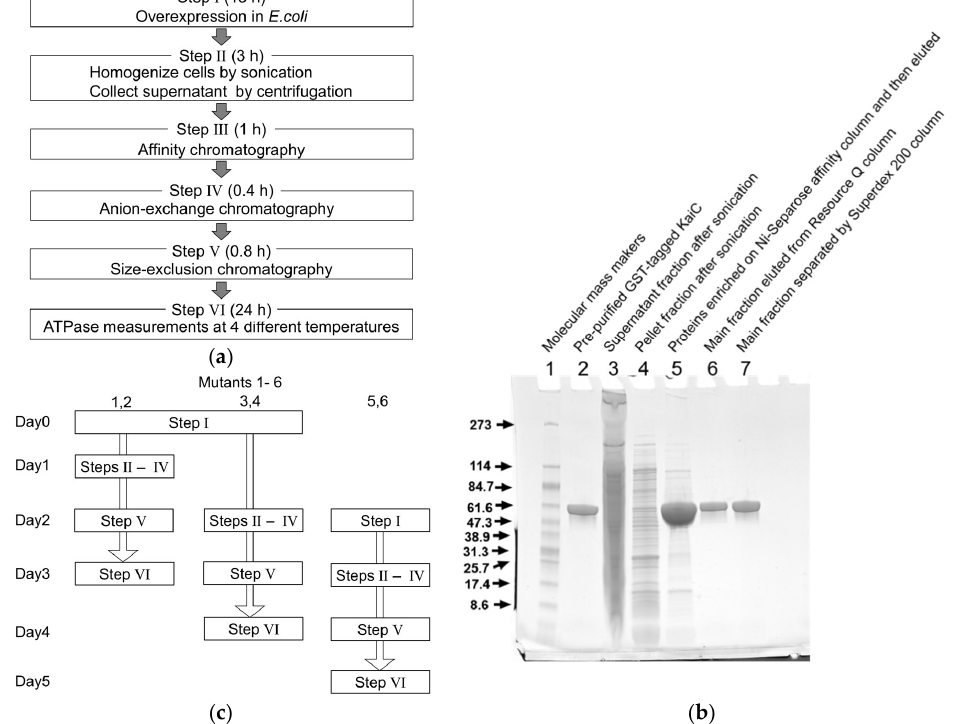
Figure 1. Optimized schemes for expression, purification, and ATPase-assay of hexa-histidine (His)-tagged KaiC. ( a ) Overview of the protocol. ( b ) Sodium dodecyl sulfate-polyacrylamide gel electrophoresis (SDS-PAGE) analysis of His-tagged KaiC during its purification. Lane 1, molecular mass makers; lane 2, the pre-purified glutathione S -transferase (GST)-tagged KaiC; lane 3, the supernatant fraction after sonication; lane 4, the pellet fraction after sonication; lane 5, the proteins enriched on Ni-Separose affinity column and then eluted; lane 6; the main fraction eluted from Resource Q column; lane 7, the main fraction separated by Superdex 200 column. ( c ) Pseudo-parallel treatment of three sets of two KaiC mutants to achieve six KaiC mutants per